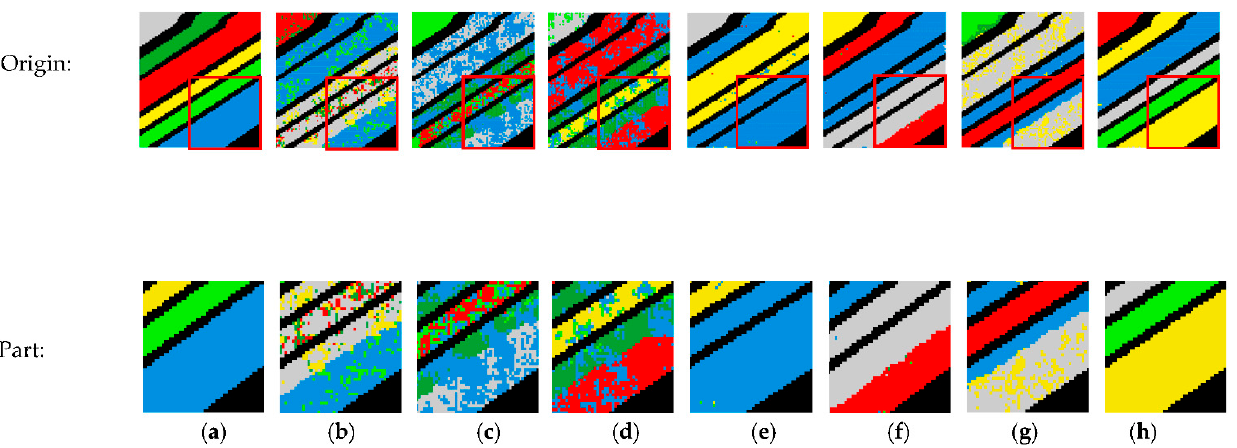
Figure 14. Clustering results obtained using different methods on the SalinasA data set with Gaussian noise and salt and pepper noise. ( a ) Ground truth. ( b ) LRSC 44.52%. ( c ) SSC 47.06%. ( d ) S4C 50.95%. ( e ) EDSC 60.79%. ( f ) EGCSC 62.23%. ( g ) EKGCSC 59.97%. ( h ) SSAKGCSC